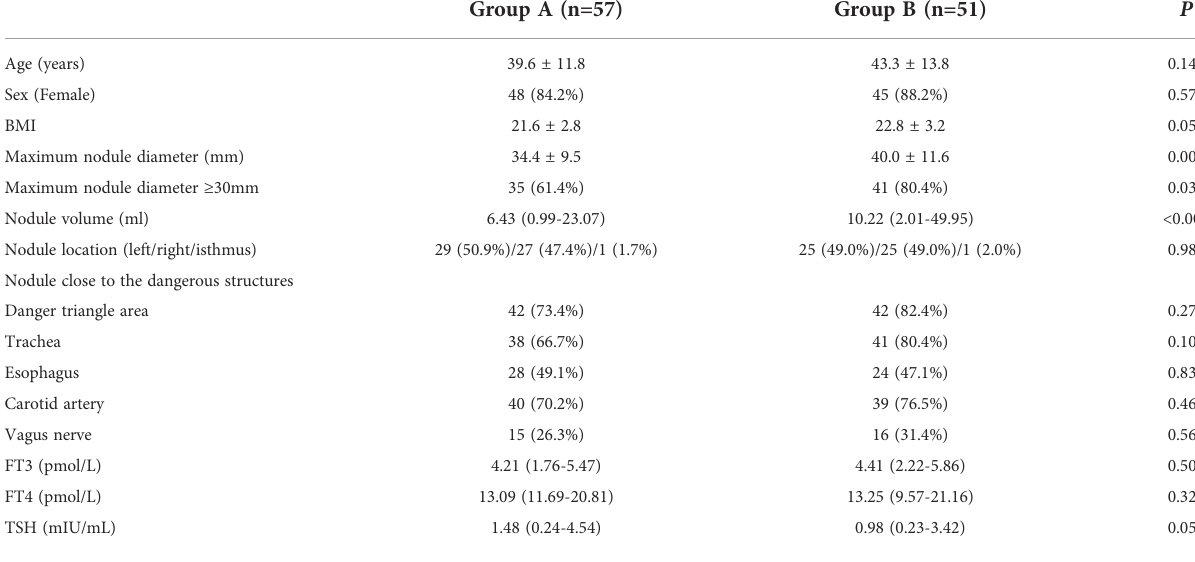
TABLE 1 Baseline characteristics and treatment characteristics of nodules of the patients and nodules in both